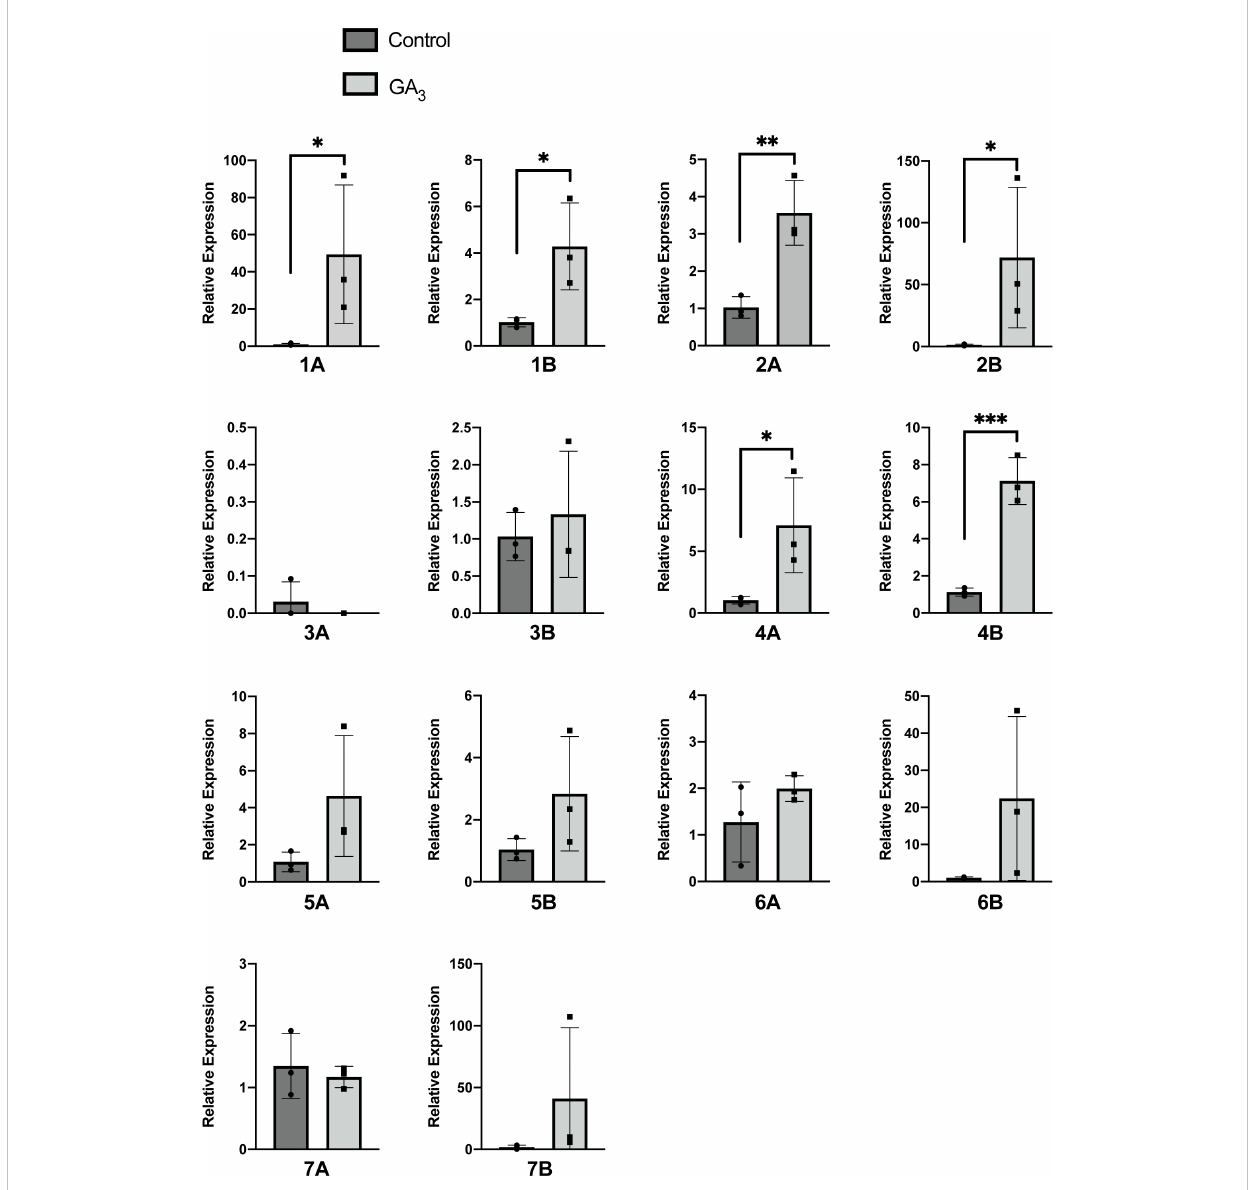
FIGURE 3 Expression of MdGA2ox genes in the apple shoot apex in response to applied GA 3 . ‘ Gala ’ trees were subjected to a foliar application of either 400 ppm of GA 3 or water (control) at 30 DAFB, and the shoot apices were collected 2 d after treatment. Black dots represent individual values from three biological replicates. Relative expression was calculated based on the expression ratio between GA2ox and a reference MdACTIN gene. An error bar indicates standard deviation among the three biological replicates, while asterisks denote statistical signi fi cance (*, p < 0.05; **, p < 0.01, ***, p <